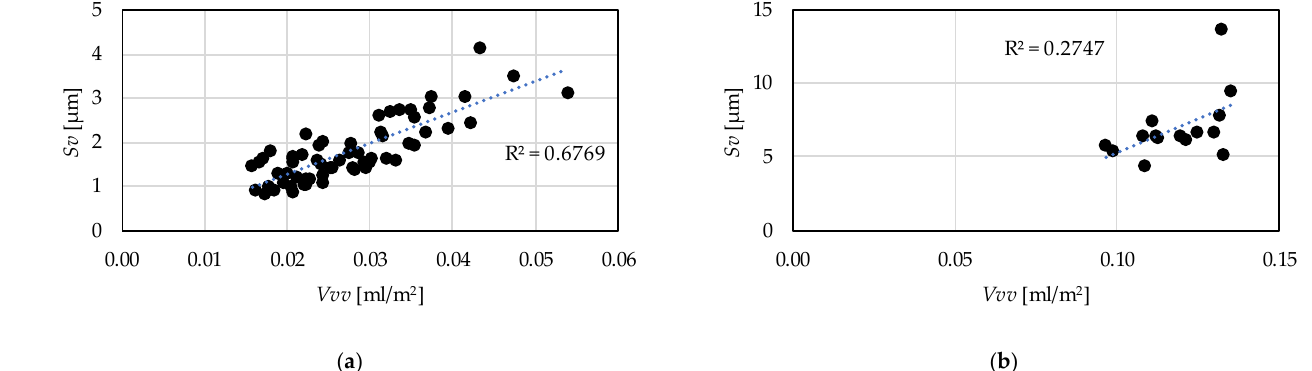
Figure 14. Connection between the valley void volume— Vvv and the maximum valley depth— Sv parameters ( a ) hard turning; ( b ) grinding.